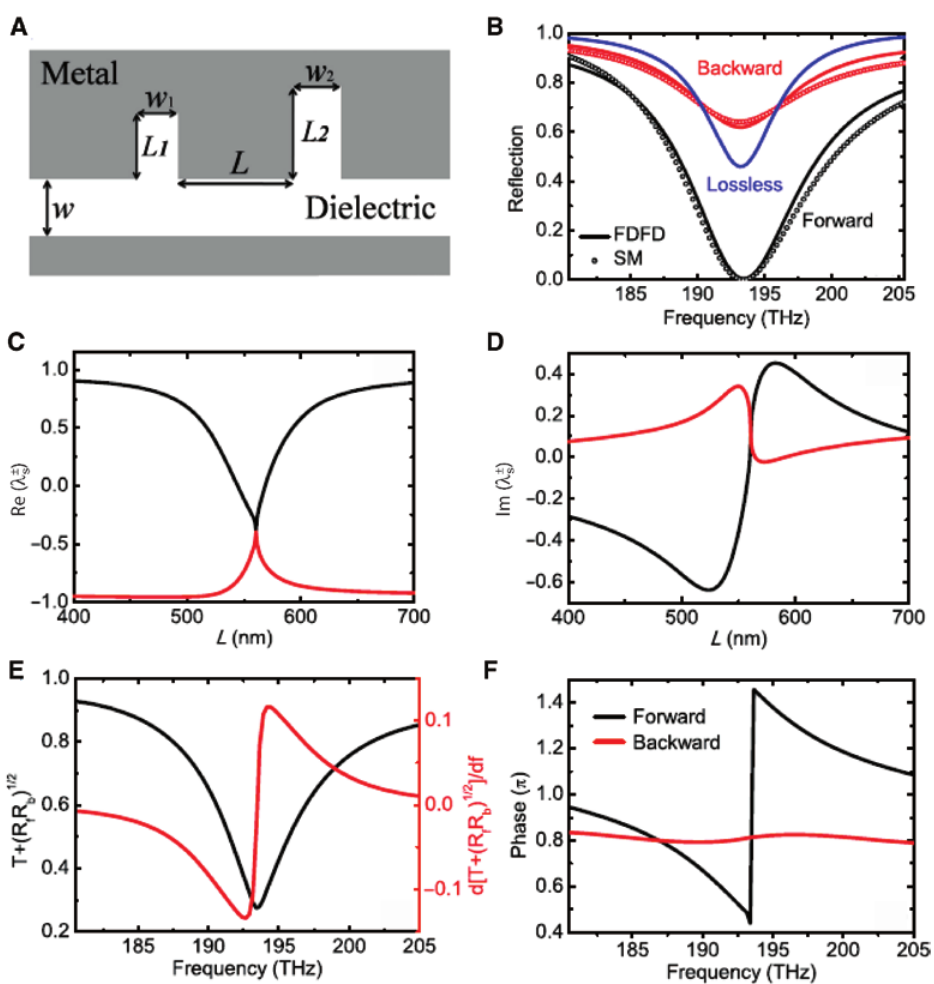
Figure 9: Unidirectional reflectionlessness of a non- PT -symmetric system consisting of a MDM plasmonic waveguide side coupled to two MDM stub